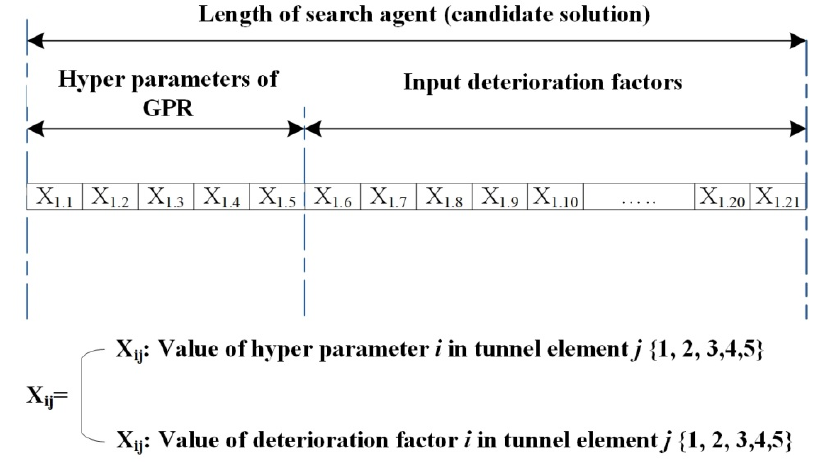
Figure 2. Schematic representation of solution structure of the GWO-GPR model. The studied kernel parameters were characteristic length scale and signal standard deviation. Three types of kernel functions were studied: exponential, Matern 3/2, and Matern 5/2. The developed model also investigates the basis function of linear, constant, and pure quadratic in addition to no basis function. The minimum and maximum bound- aries of Gaussian noise standard deviation, characteristic length scale, and signal standard deviation were set between 0 and 10, respectively. The automated calibration of the hyper parameters of Gaussian process regression was carried out based on a single-objective opti- mization function that minimizes mean absolute percentage error of the condition rating of tunnel elements, as shown in Equation (14). Mean absolute percentage error was selected